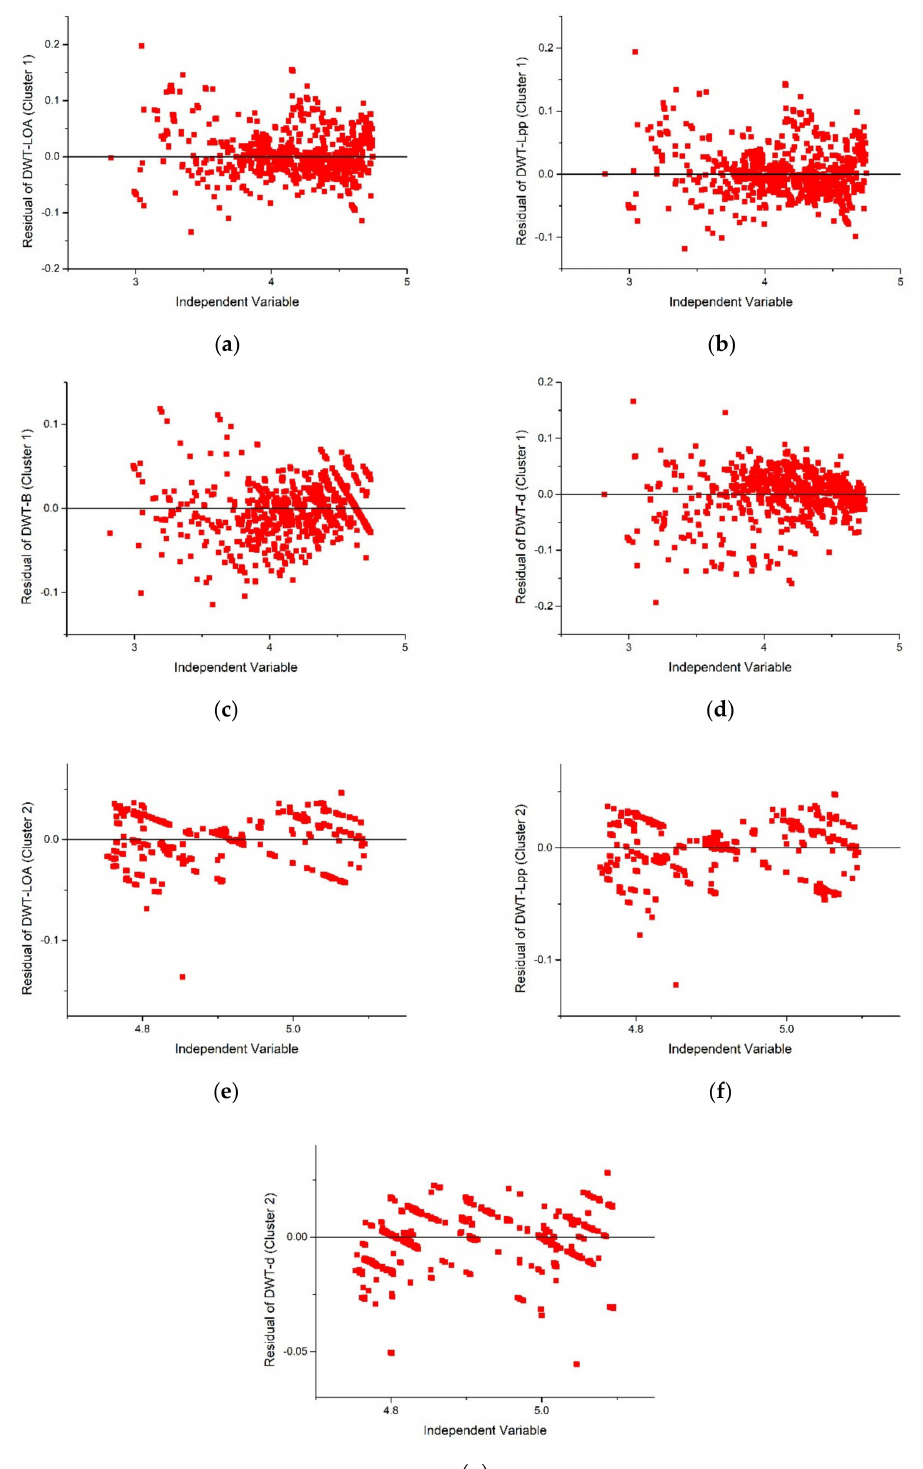
Figure 17. Results of log transformed linear regression graph residual homoscedasticity. ( a ) Dead- weight tonnage (DWT)-Length overall (LOA) graph of Cluster 1; ( b ) DWT-Length between perpen- diculars (Lpp) graph of Cluster 1; ( c ) DWT-breadth (B) graph of Cluster 1; (d DWT-draft ( d ) graph of Cluster 1; ( e ) DWT-LOA graph of Cluster 2; ( f ) DWT-Lpp graph of Cluster 2; ( g ) DWT-d graph of Cluster